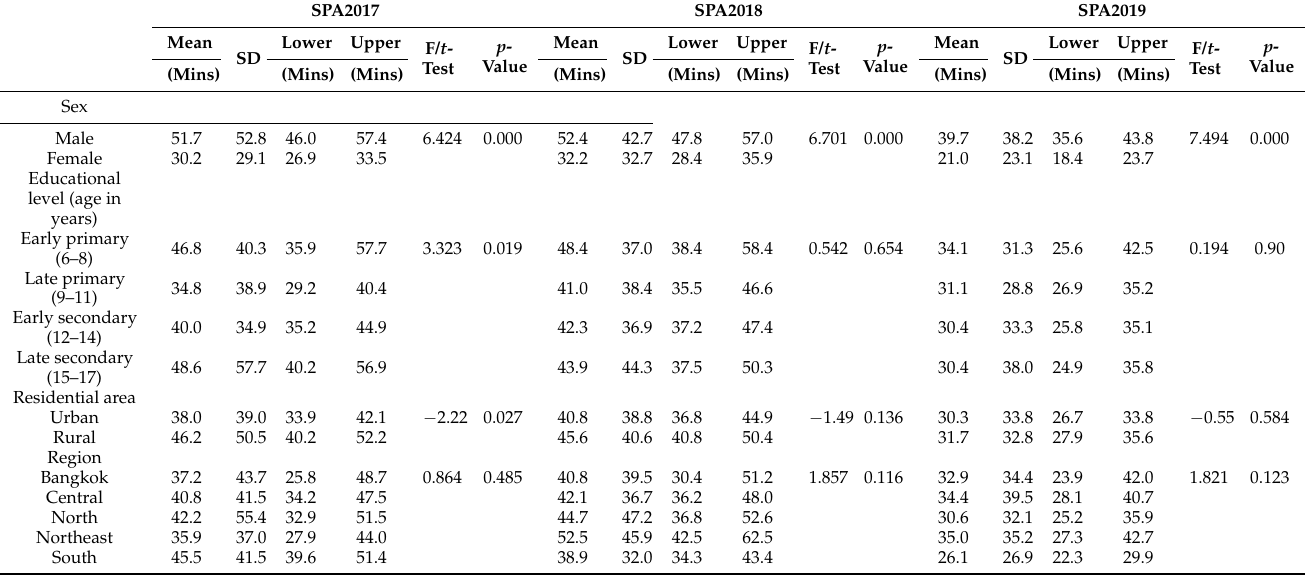
Table 4. Average daily MVPA among Thai children and young people